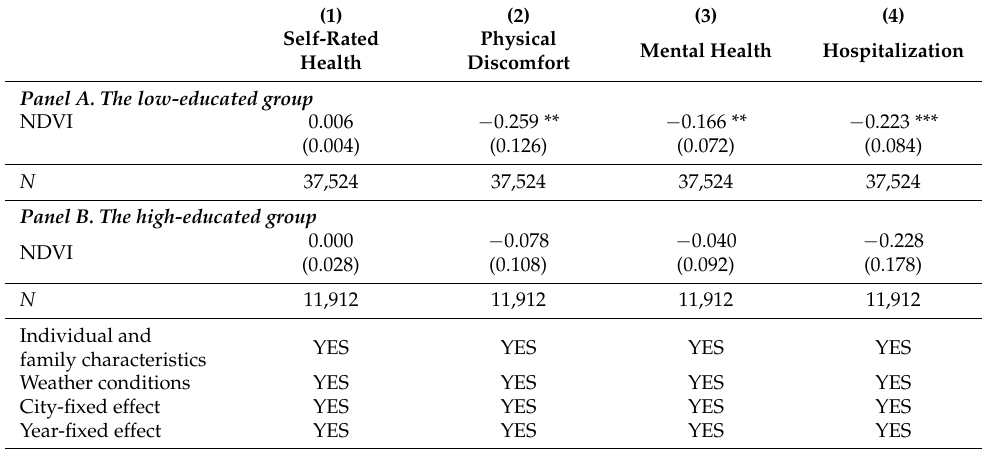
Table 3. Heterogeneous effect of greenspaces by education